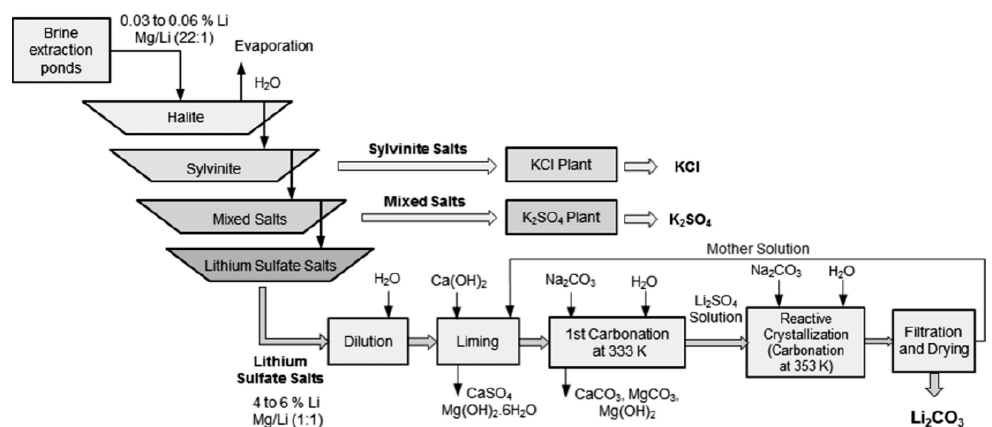
Figure 1. Flowsheet of the alternative pilot process used to produce Li 2 CO 3 from brines with high Mg / Li ratios developed by COMIBOL. Reproduced with permission from Paola G. Aguilar and Teofilo A. Graber, Industrial and Engineering Chemistry Research; published by American Chemical Society, 2018.